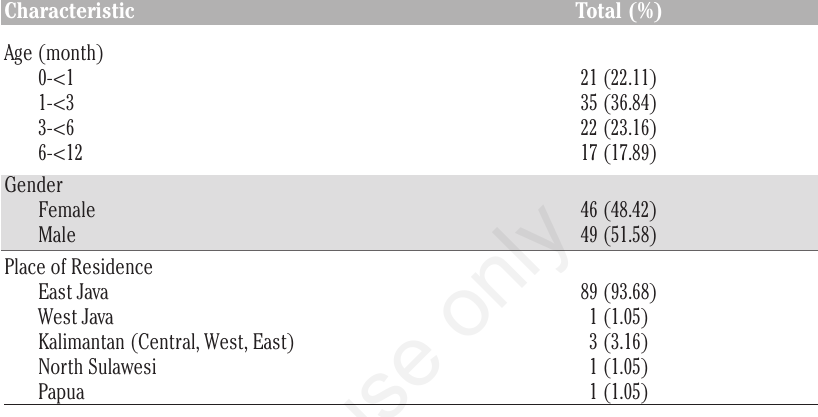
Table 1. Characteristic of Congenital Rubella Syndrome in Dr. Soetomo Hospital, Surabaya.